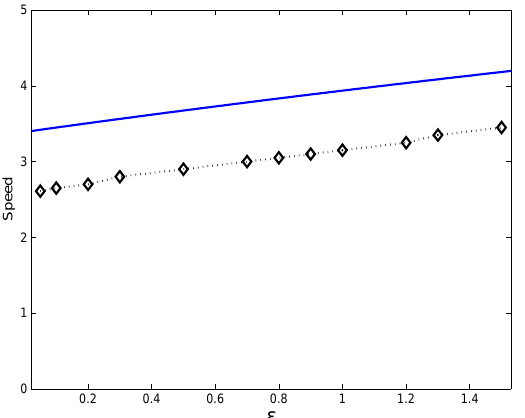
Figure 13. Dependence of the speed of the travelling peak on (cid:101) ; diamonds show the numerical results, and the blue line shows the analytical estimate